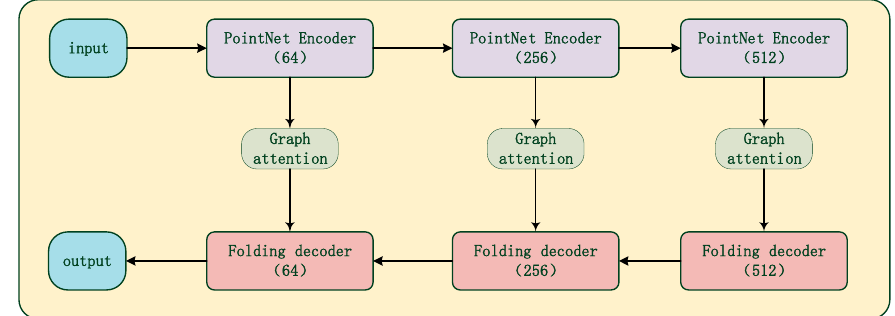
Figure 4. Encoder–decoder